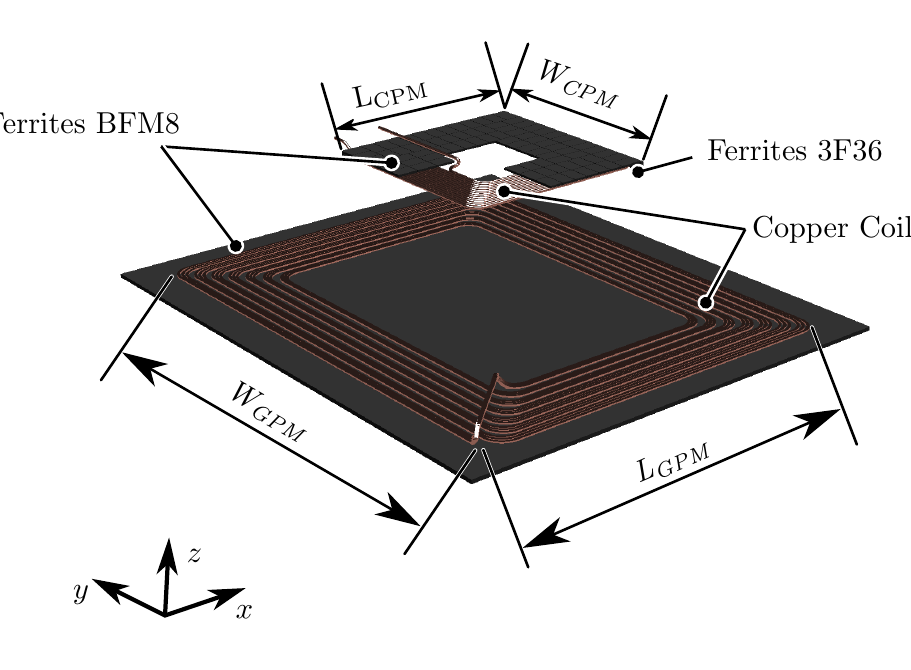
Figure 4. Design parameters of the exemplary WPTS. Table 2. Coil parameters of proposed 11 kW